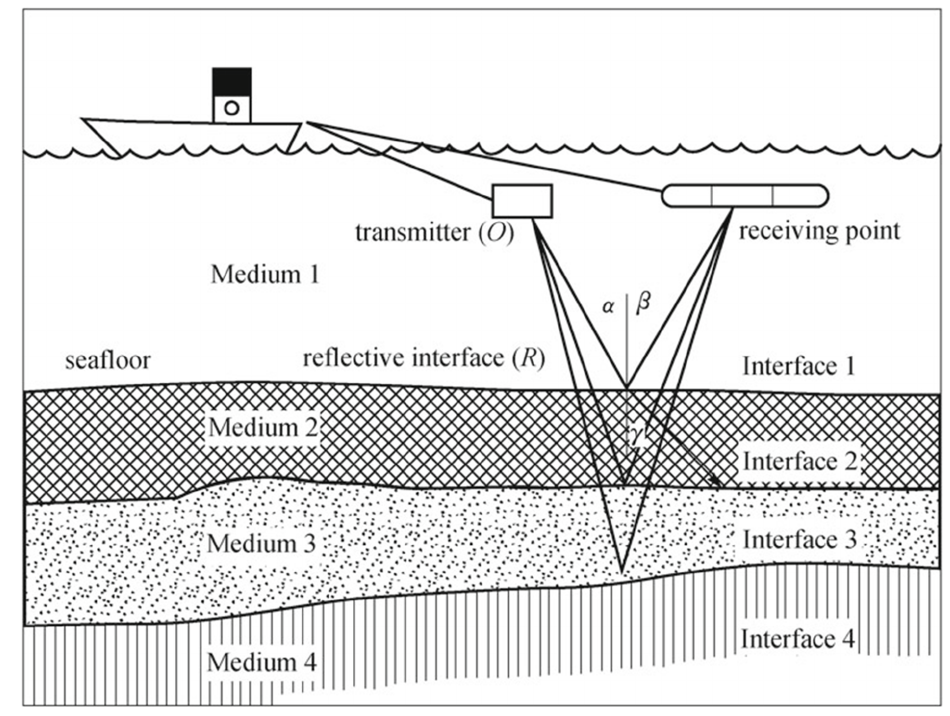
Figure 3. Working principle of sub-bottom profiler detection